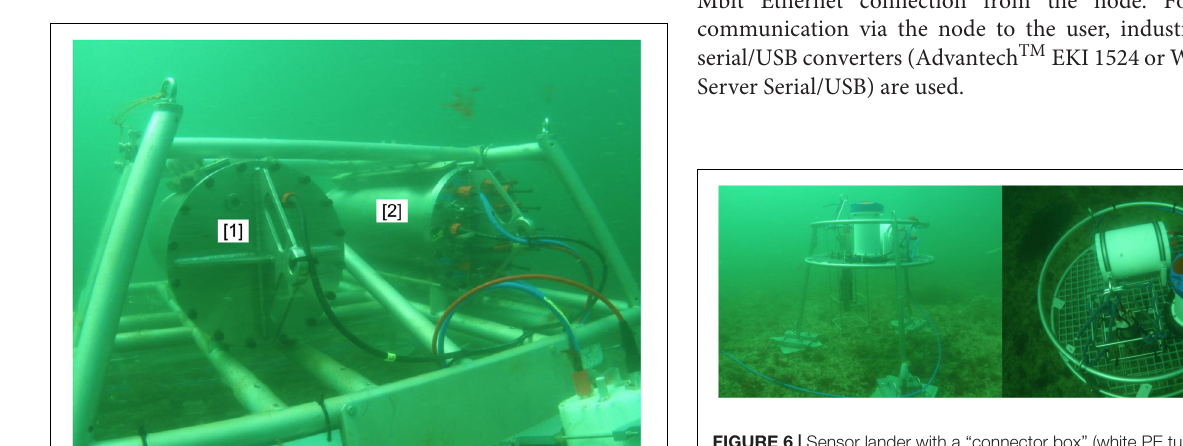
FIGURE 6 | Sensor lander with a “connector box” (white PE tube in the right image). The “connector box” is connected to the “breakout box.” From